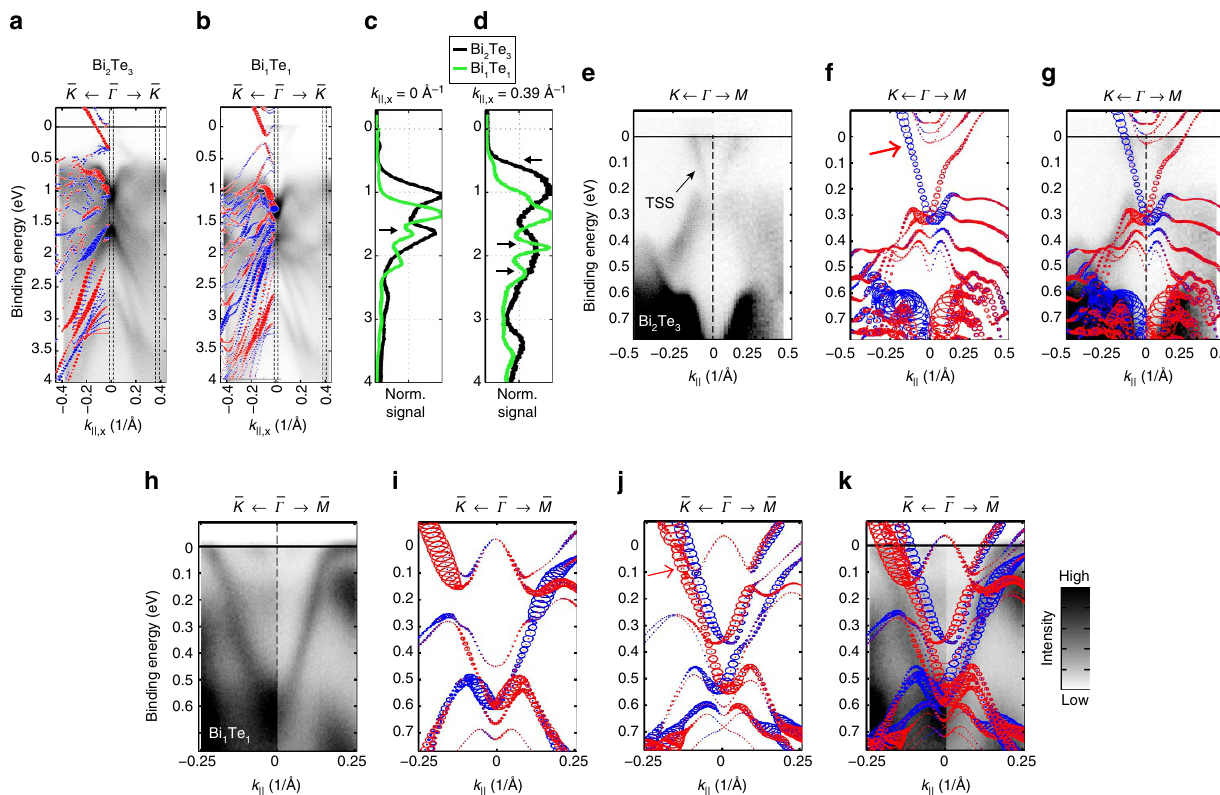
Figure 3 | Band structure of Bi 2 Te 3 and Bi 1 Te 1 . Comparative wide energy range ARPES spectra along G K direction of thin films of ( a ) Bi 2 Te 3 and ( b ) Bi 1 Te 1 measured at T E 25K using h n ¼ 21.2eV. The colour code in the experimental spectra scales from bright ¼ low to dark ¼ high intensity. Superimposed are the results from the corresponding spin-polarized DFT calculations (1QL termination from Fig. 2 is used; red and blue dots mark opposite in-plane spin channels). ( c , d ) Energy distribution curves obtained along the dashed areas in a , b , respectively, at ( c ) k ||, x ¼ 0Å (cid:2) 1 and ( d ) 0.39Å (cid:2) 1 (black curve from Bi 2 Te 3 and green curve from Bi 1 Te 1 ). Black arrows mark prominent spectral differences. Magnified electronic structure close to the Fermi level along indicated crystallographic directions are shown in e for Bi 2 Te 3 at h n ¼ 21.2eV and in h for Bi 1 Te 1 at h n ¼ 8.4eV. Additionally, the corresponding calculations are shown in f for Bi 2 Te 3 , and in i – j for Bi 1 Te 1 (( i ) 1QL termination, ( j ) 2QL termination), and superimposed on the experimental spectra in g , k , respectively (( k ) shows overlap with ( i ) and ( j )). The Fermi energy in the calculated spectra was shifted up by 100meV (200meV) in the 1QL (2QL) Bi 1 Te 1 case compared to Fig. 2, and by 250meV for the Bi 2 Te 3 case. Red arrows point to a single spin-polarized band in Bi 2 Te 3 ( f ), and two overlapping bands with opposite spin polarization for Bi 1 Te 1 ( j